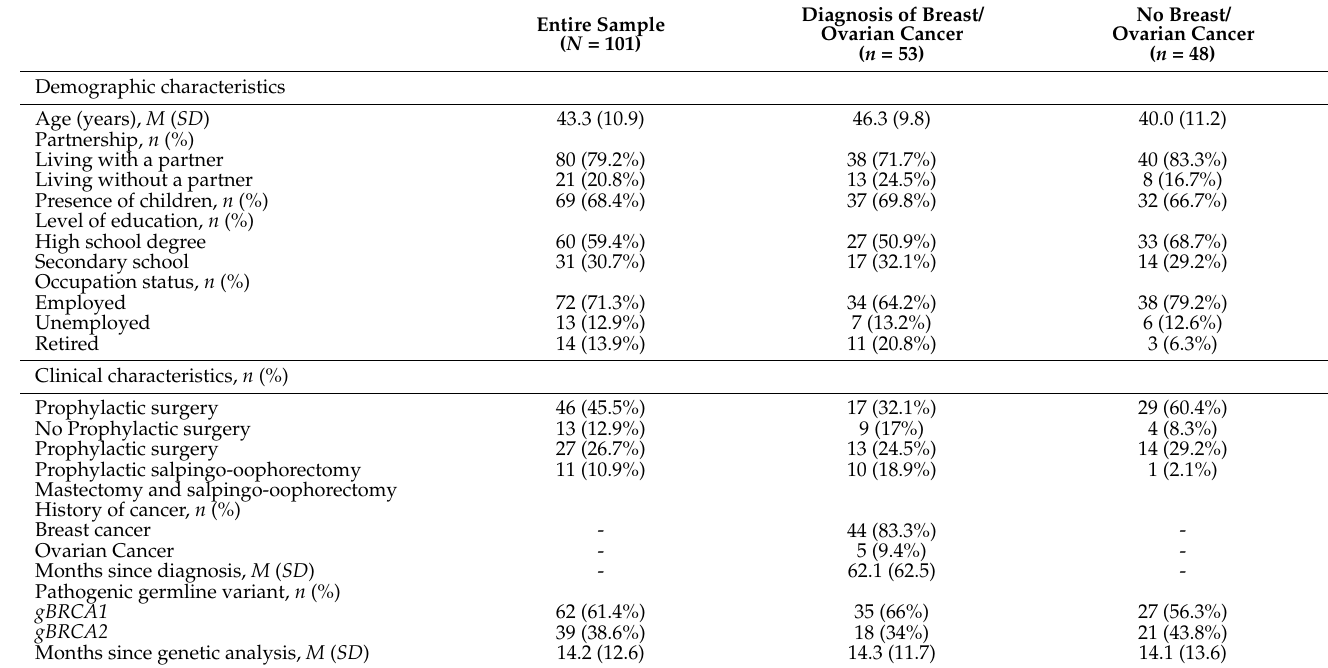
Table 1. Demographic and clinical characteristics of the entire study population and according to breast and/or ovarian cancer